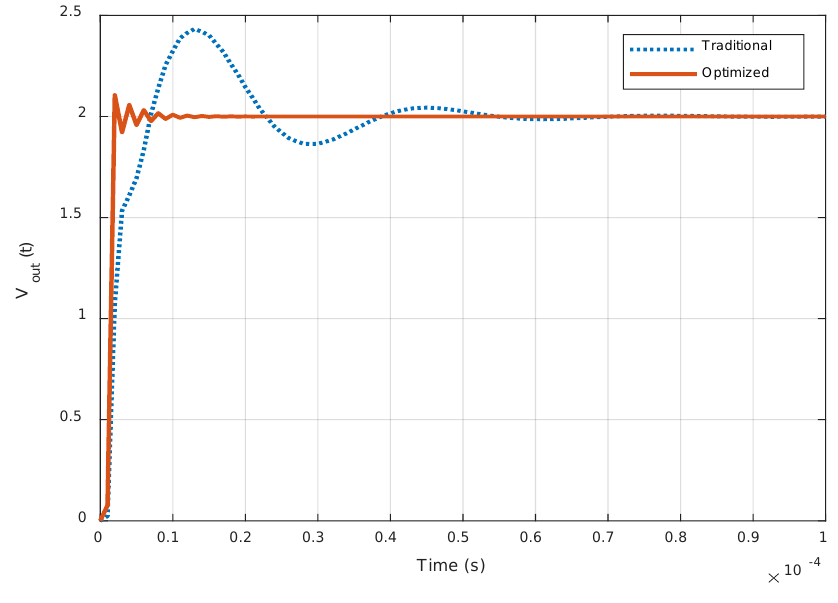
Figure 14. Controllers’ output voltage response. Table 4. Comparison of performance characteristics.